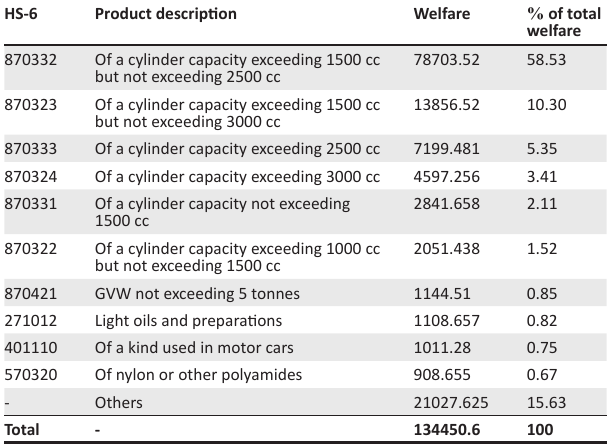
TABLE 6: Top 10 products with largest consumer welfare after the Free Trade Agreement with the European Union (US$ 000). HS-6